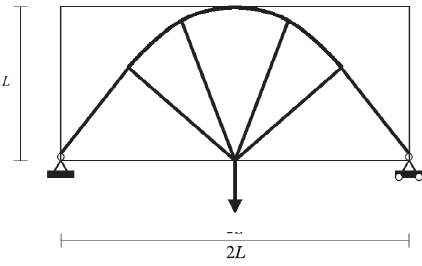
Fig. 7. Ideal solution of the Michell truss.